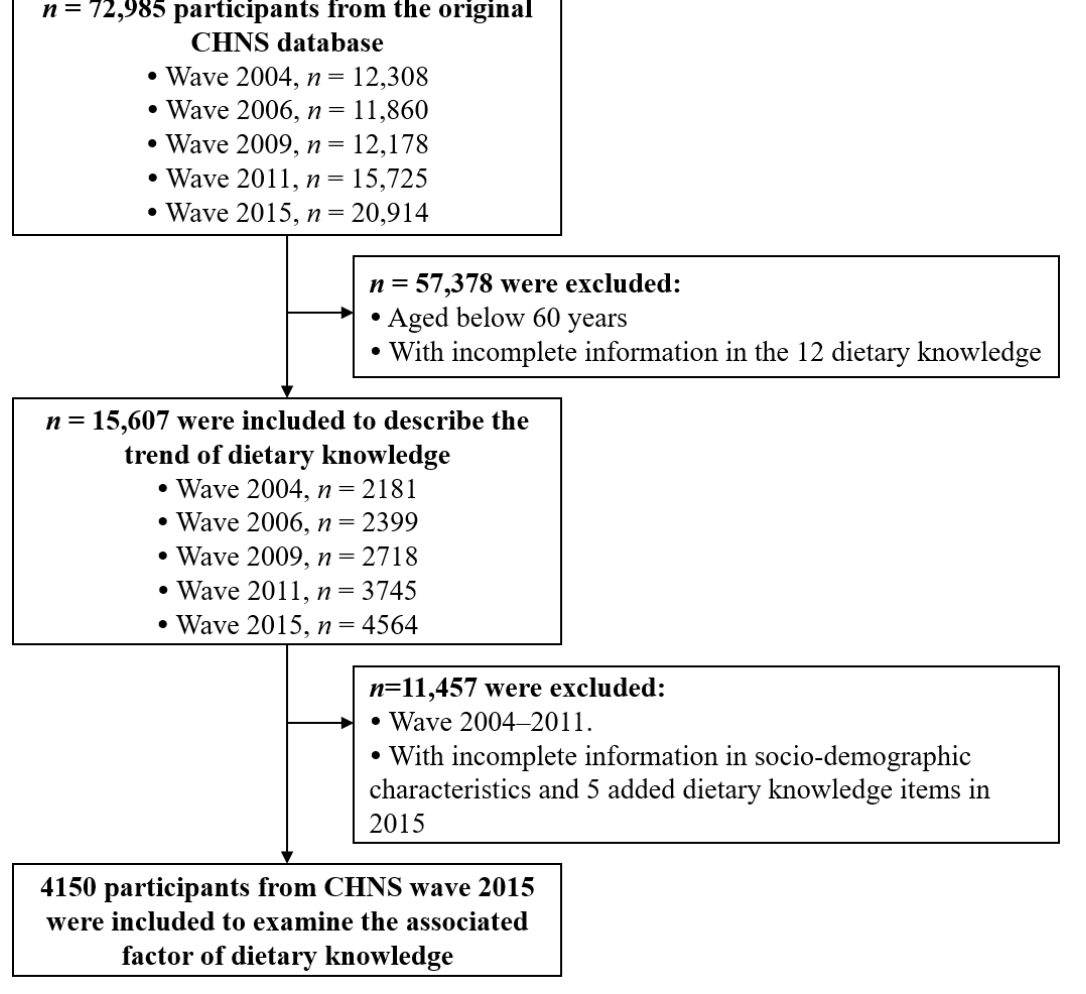
Figure 1. Flow diagram for the sample selection.